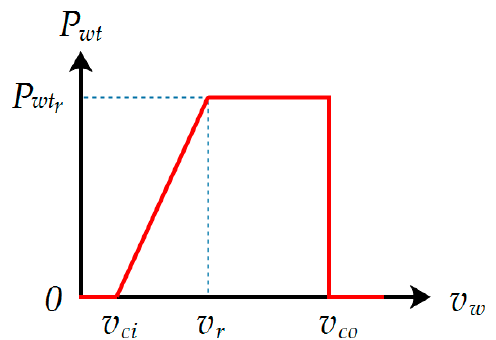
Figure 3. The output power curve of a typical wind turbine.